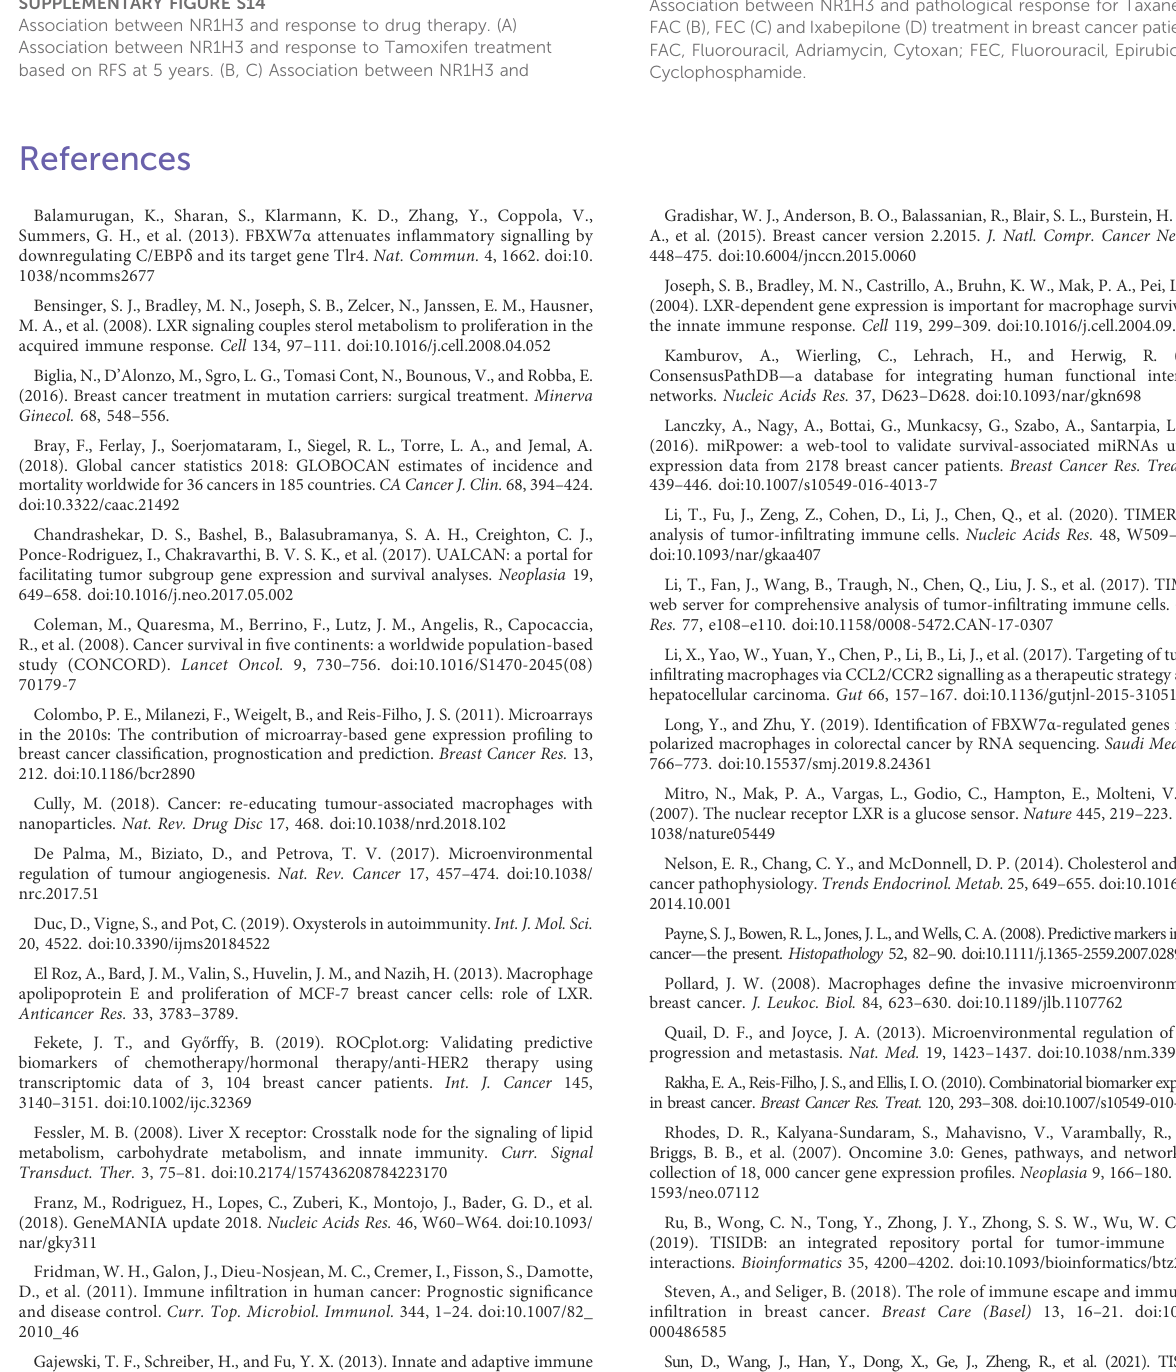
SUPPLEMENTARY FIGURE S14 Association between NR1H3 and response to drug therapy. (A) Association between NR1H3 and response to Tamoxifen treatment based on RFS at 5 years. (B, C) Association between NR1H3 and